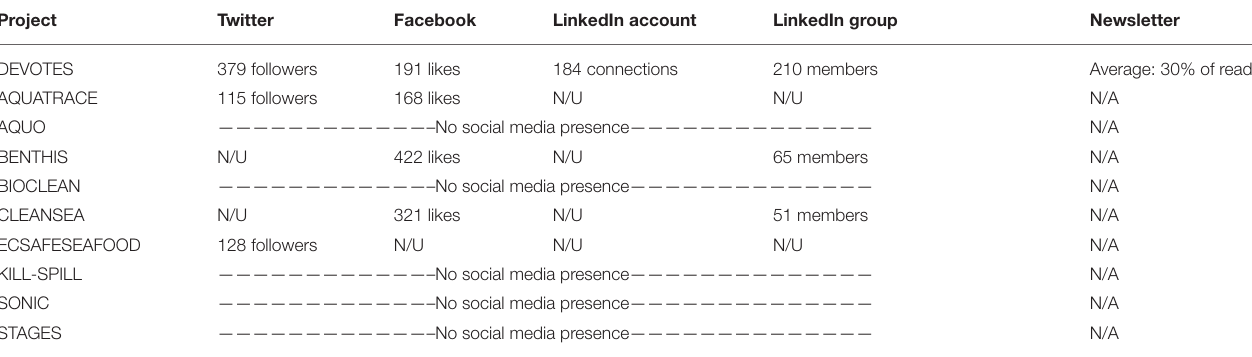
TABLE 2 | E-media users in DEVOTES and other EU projects in the framework of Ocean of Tomorrow initiative (FP7-OCEAN). Project